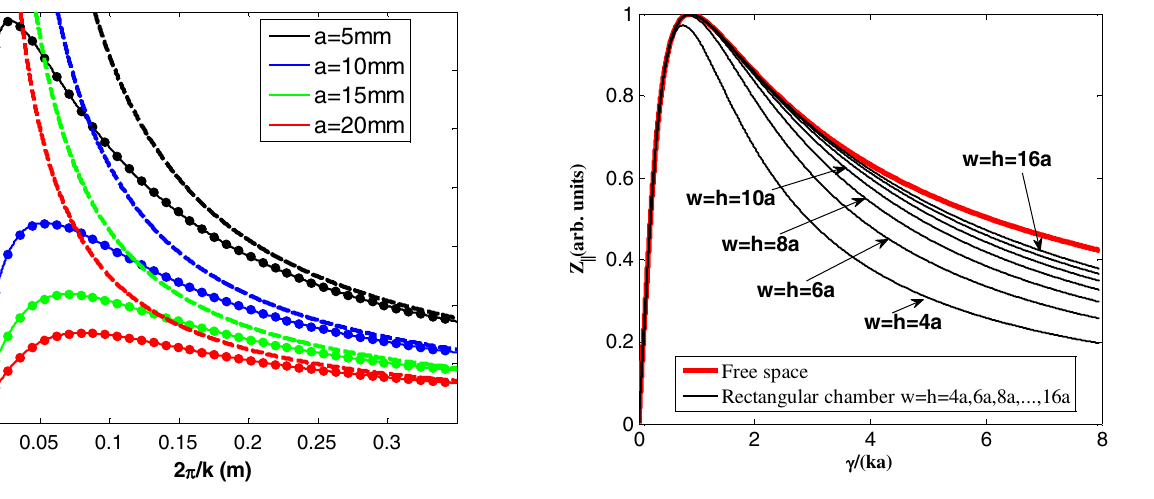
FIG. 9. Comparison of the on-axis LSC impedances of a round transversely uniform beam centered inside the SIR rectangular chamber between analysis (solid lines) and FEM simulations (solid dots). The LSC impedances predicted by the long- wavelength-limit formula (dashed lines) are also shown for comparison. The parameters used in the calculations are w ¼ 11 . 4 cm, h ¼ 4 . 8 cm, the variable beam radii are a ¼ 0 . 5 , 1.0, 1.5 and 2.0 cm in this study. The circumference of SIR is 6.58